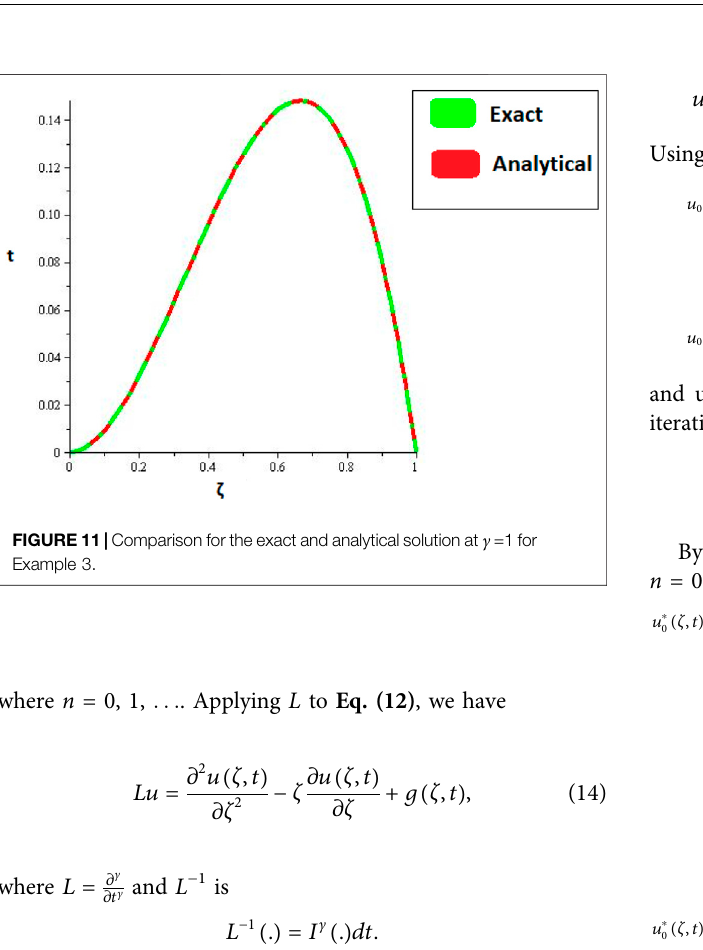
FIGURE 10 | 2D plots for the exact and analytical solution at γ =1 for Example 3.